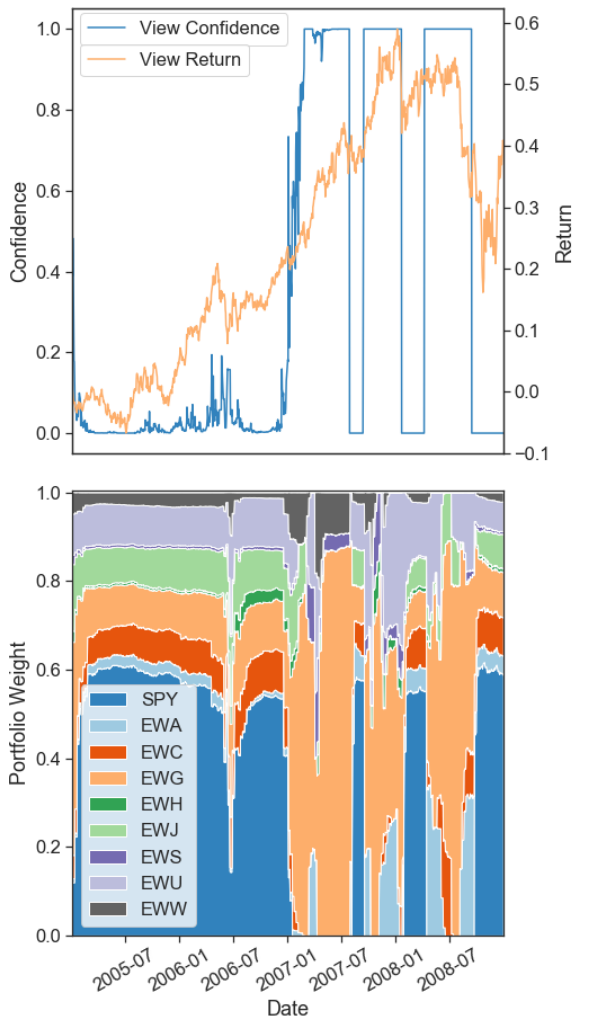
Figure 13. Portfolio Weights versus Confidence in the Long EWG, Short SPY View